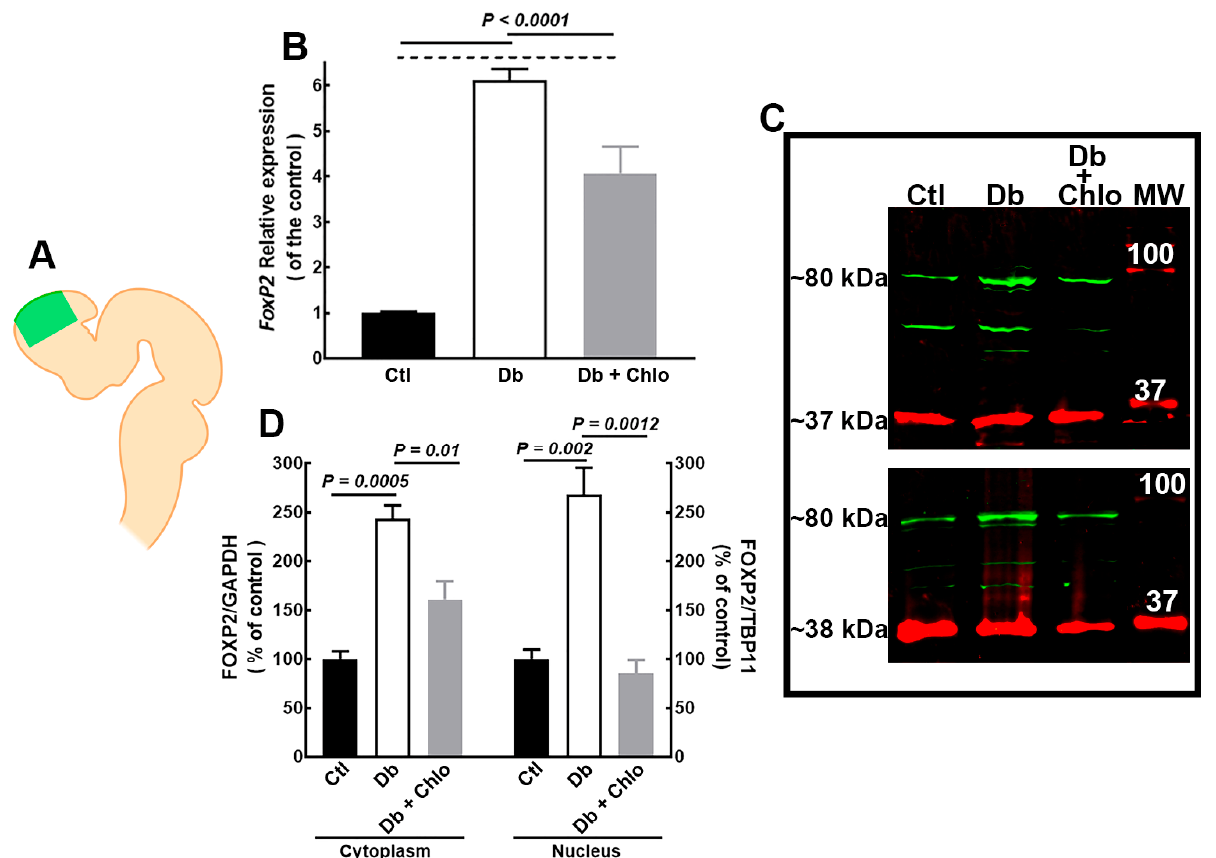
Figure 1. FOXP2 expression in the cortical neuroepithelium at 14-day-old embryos. ( A ) Image showing the E14 neural tube. In green is highlighted the dorsal telencephalon dissected for qRT-PCR and Western blot analysis. Created with BioRender.com (1 January 2023). ( B ) FoxP2 expression in E14 dorsal telencephalon from control (Ctl), diabetic (Db), and Chlorpheniramine-treated diabetic (Db + Chlo) groups. Gapdh amplification was used as an internal control. Values (means ± S.E.M., n = 5) are expressed as the relative expression of the control using the 2 −ΔΔ CT method. ( C ) Representative FOXP2 (green, ~80 kDa) Western blots of cytoplasmic (up) and nuclear (down) protein extracts. GAPDH (red, ~37 kDa) and TBP1 (~38 kDa) were used as internal controls for cytoplasm and nuclear fractions, respectively. ( D ) Quantitative fluorometry analysis of FOXP2. Values (means ± S.E.M., n = 4) are expressed as a percentage of the control fluorescence ratio. The two-way ANOVA, followed by Tukey’s multiple comparisons test, was performed, and the significant P values are shown in the graphs. MW = molecular weight ladder.